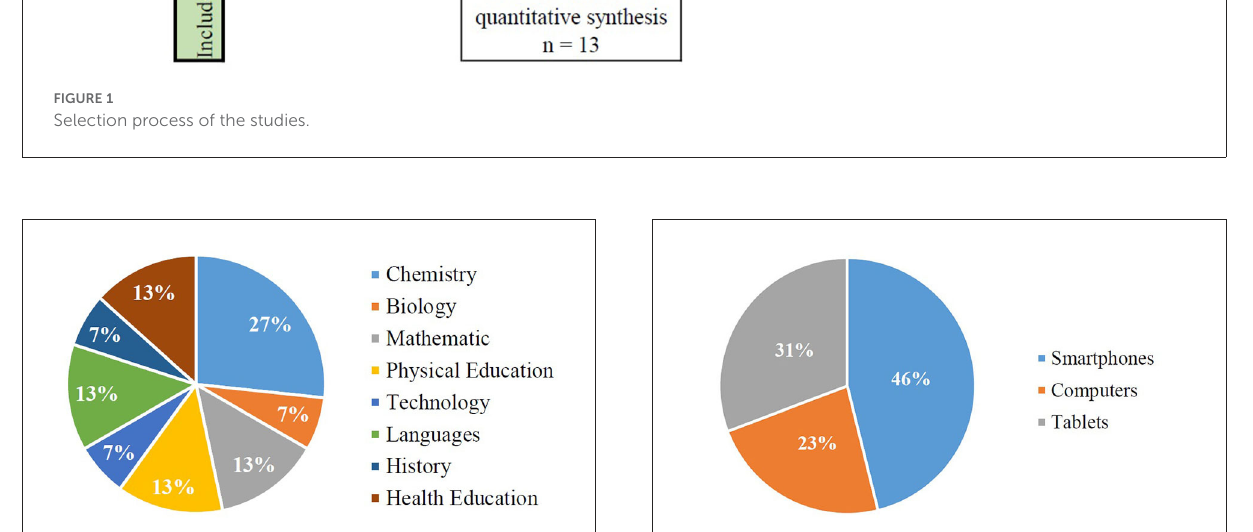
FIGURE2 Application areas or subjects in Augmented Reality.